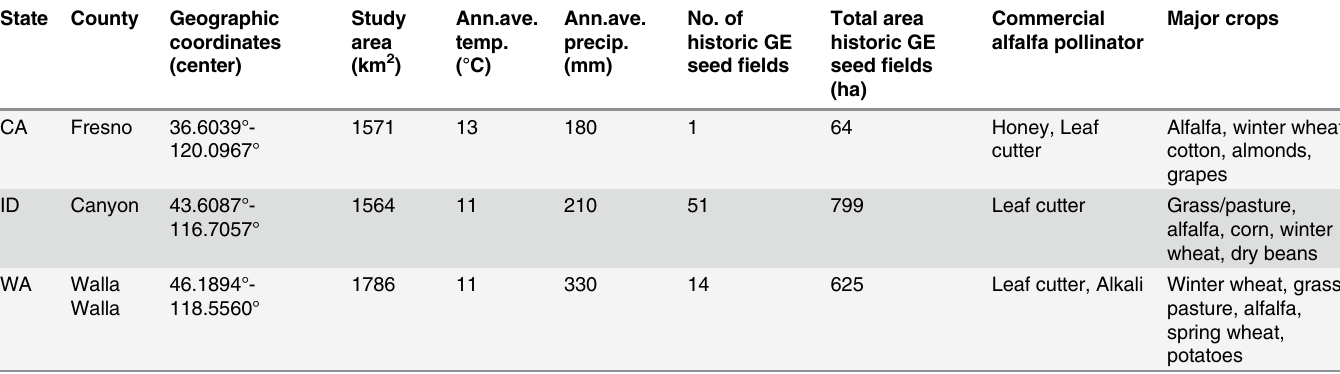
Table 1. Location, size, climate, and crop characteristics of three areas in the western United States surveyed for feral alfalfa. State County Geographic